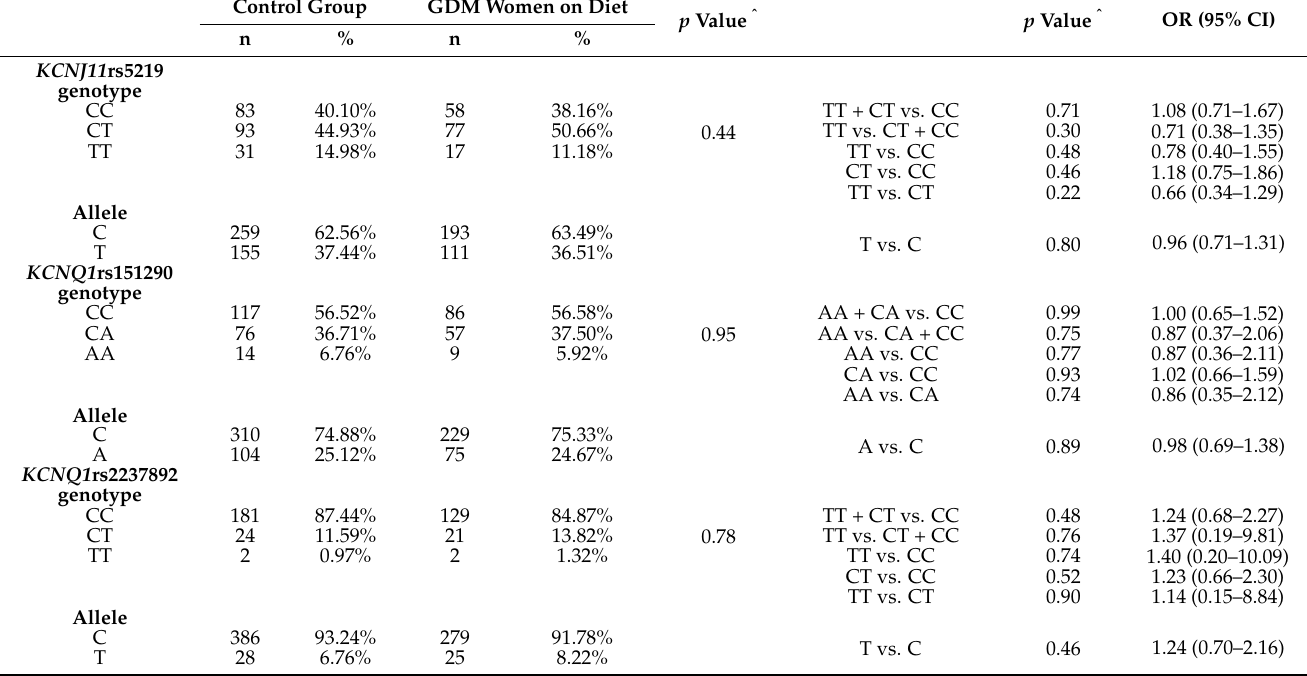
Table 3. Distribution of KCNJ11 and KCNQ1 genotypes in GDM women on diet and control group.